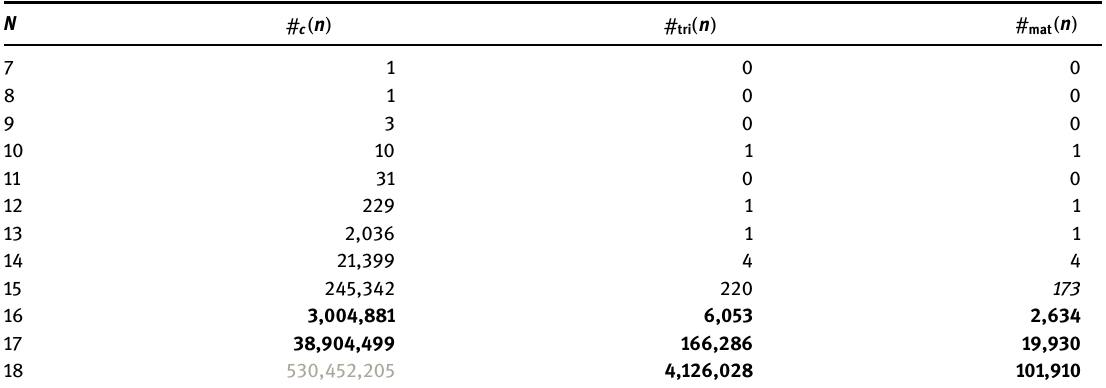
Table 1: n 3 - con fi gurations inducing triangular matroids and the number of non - isomorphic triangular matroids induced